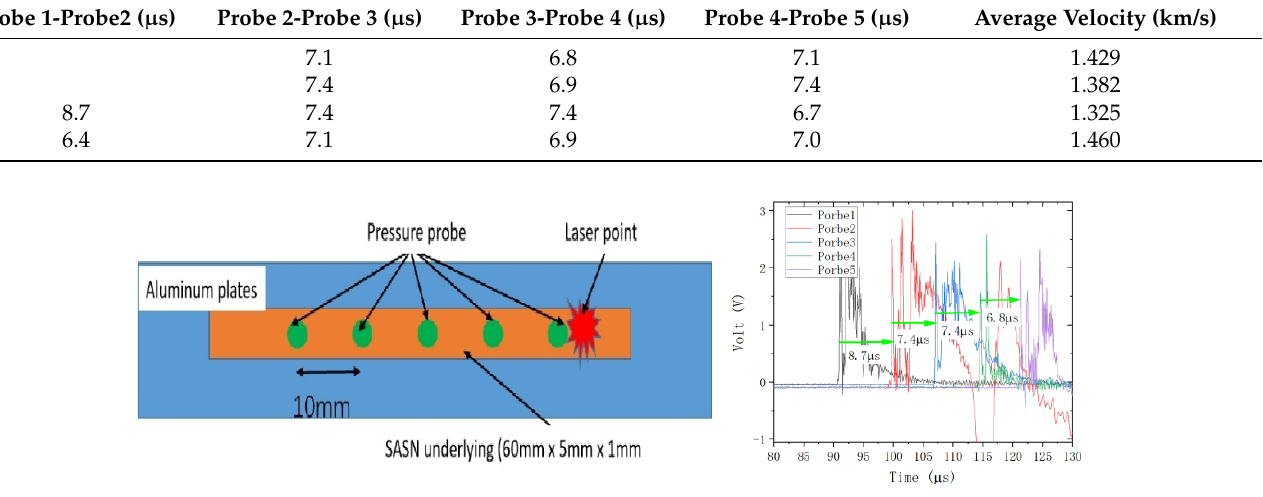
Figure 11. Measurement system and actually measured